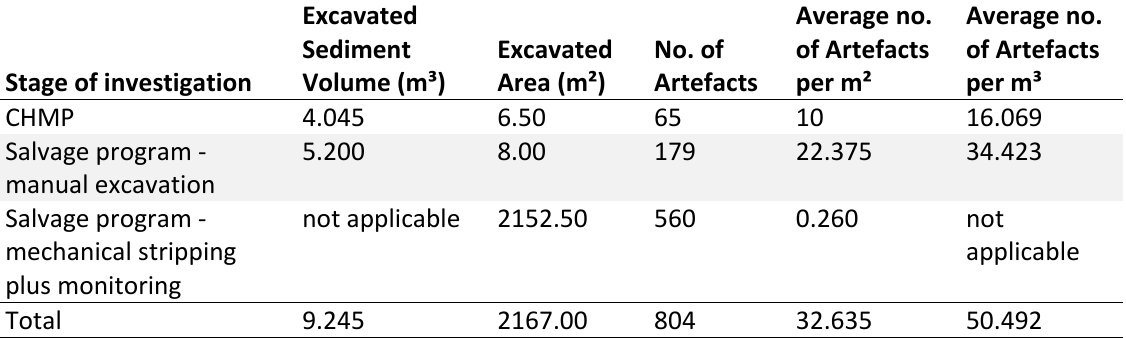
Table 1: VAHR 7721-1241 Artefact density (based on subsurface testing undertaken by Light & Tuechler (2014) and Tuechler & Spry